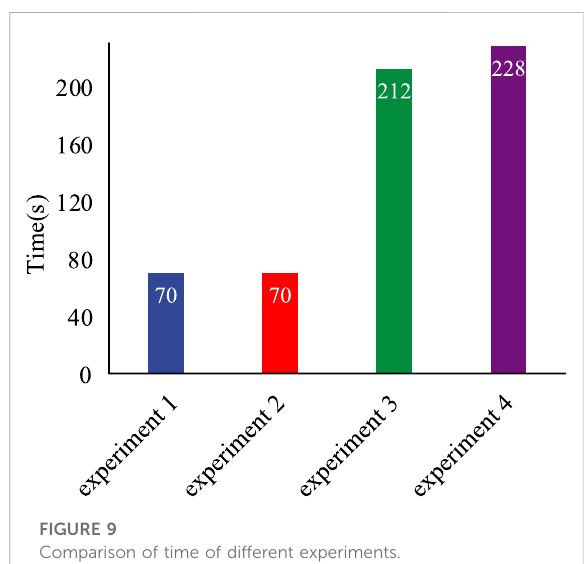
FIGURE 9 Comparison of time of different